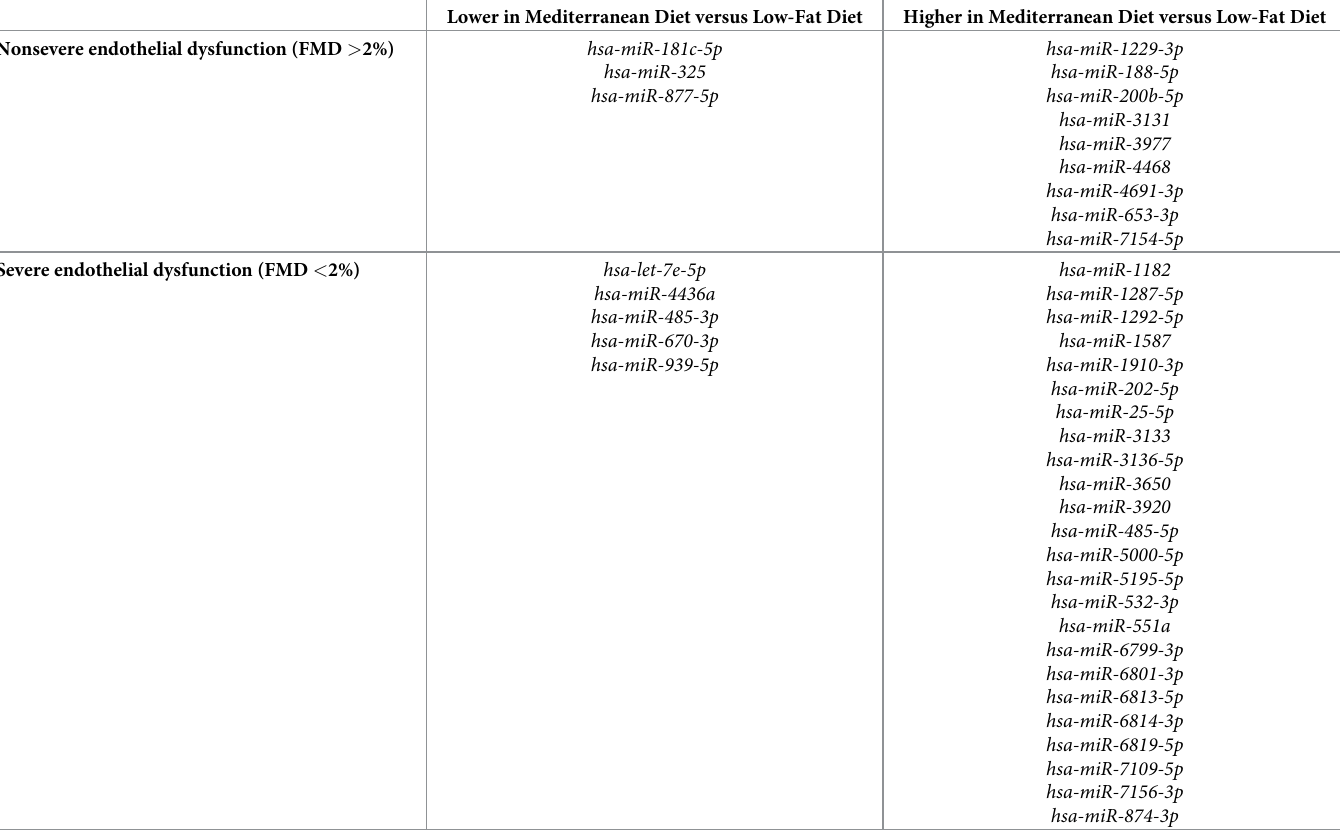
Table 4. Changes in miRNA profile after dietary intervention in CHD patients classified according to the severity of endothelial dysfunction. Lower in Mediterranean Diet versus Low-Fat